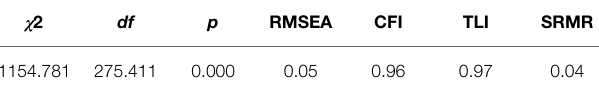
TABLE 4 | Descriptive analysis of teachers’